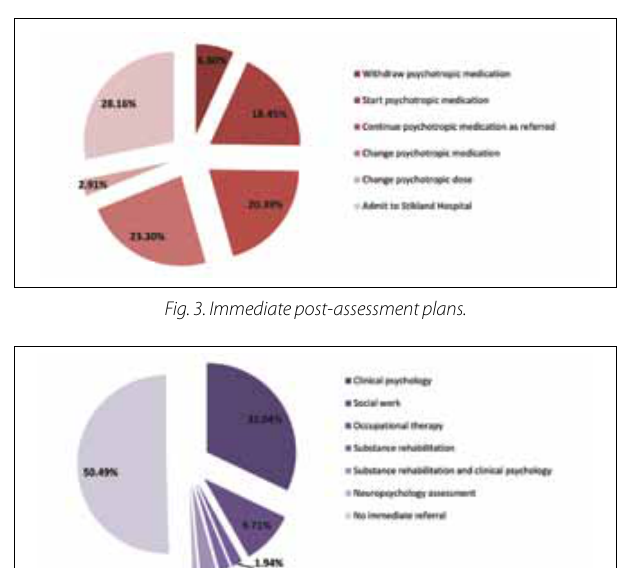
Fig. 2. Post-assessment DSM-IV Axis I diagnoses.